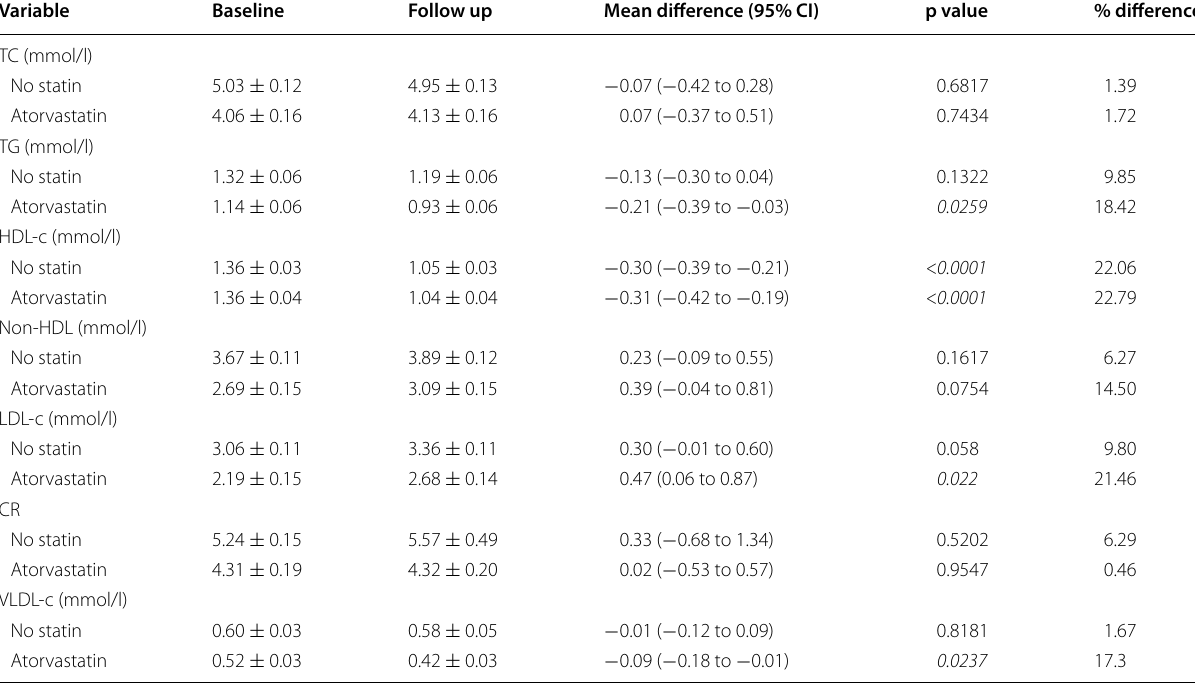
CI confidence interval